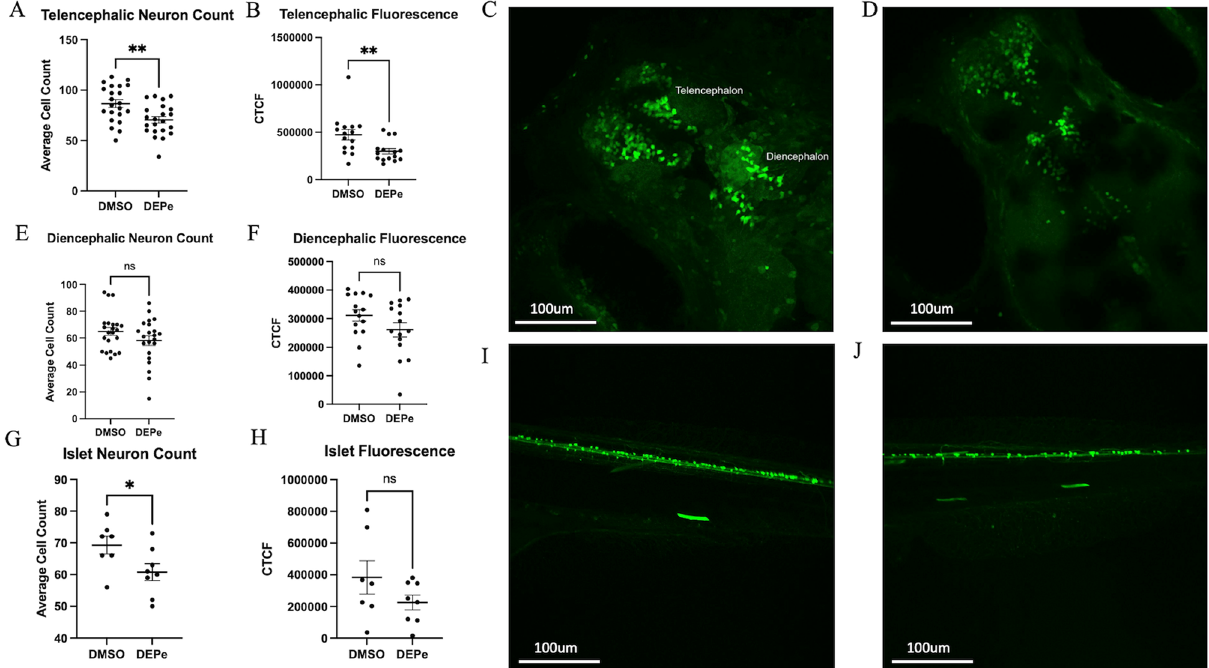
Figure 1. DEPe-induced neurotoxicity. Significant loss of telencephalic neurons and GFP fluorescence with DEPe exposure ( A , B ). Dorsal view of 5dpf DMSO- ( C ) and DEPe-treated ( D ) vmat2:GFP ZF brains. No significant change in diencephalic neuron numbers ( E ) or fluorescence ( F ) with DEPe exposure. **p < 0.01, n = 22, 15 (DMSO, DEPe). Significant loss of islet neurons with DEPe exposure ( G ) but no significant loss of islet fluorescence ( H ) with DEPe exposure. Lateral view of 5dpf DMSO-treated ( I ) and DEPe-treated ( J ) Tg(isl1[ss]:Gal4-VP16,UAS:eGFP) zf154 tail. *p < 0.05, n = 7, 8 (DMSO, DEPe). Student’s T-test; error bars represent